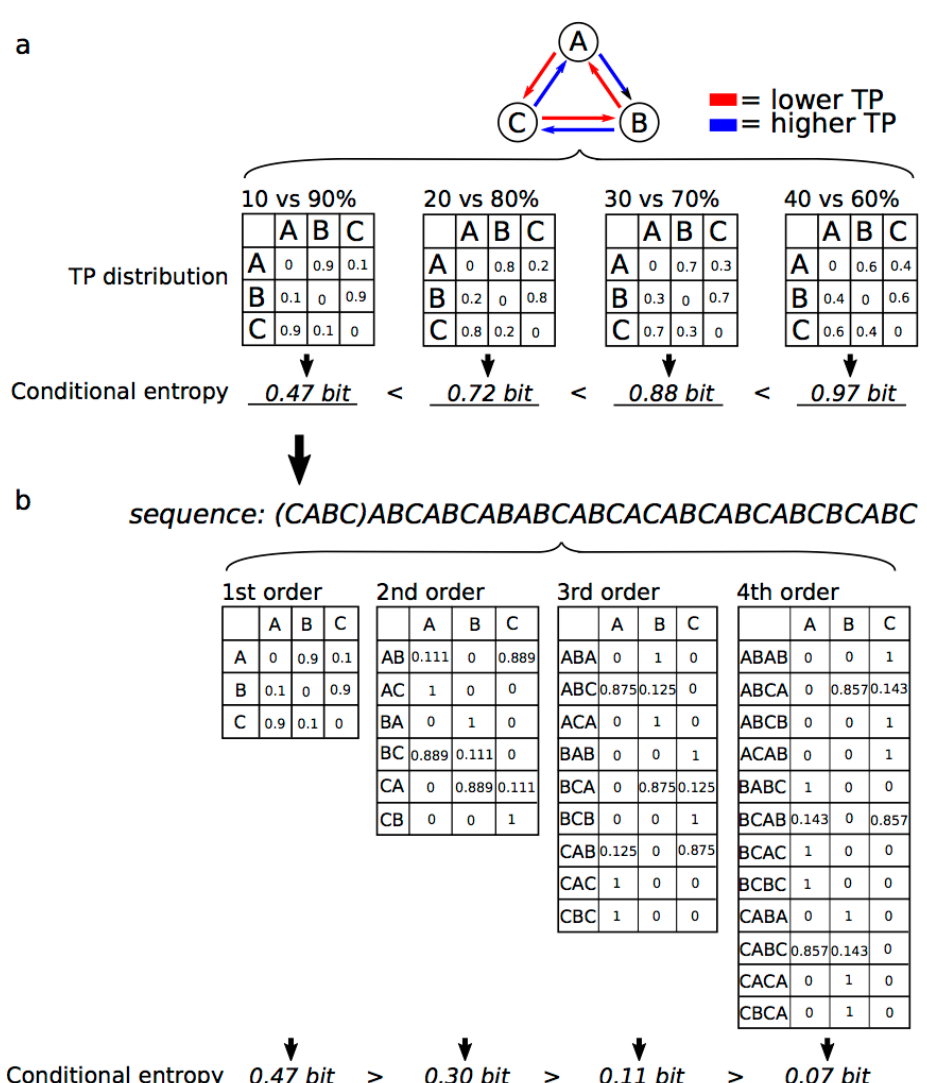
Figure 3. The entropy (uncertainty) of predictability in the framework of SL. The uncertainties depend on ( a ) TP ratios in a first-order Markov model (i.e., bigram model) and ( b ) orders of models in the TP ratio of 10% vs. 90%.